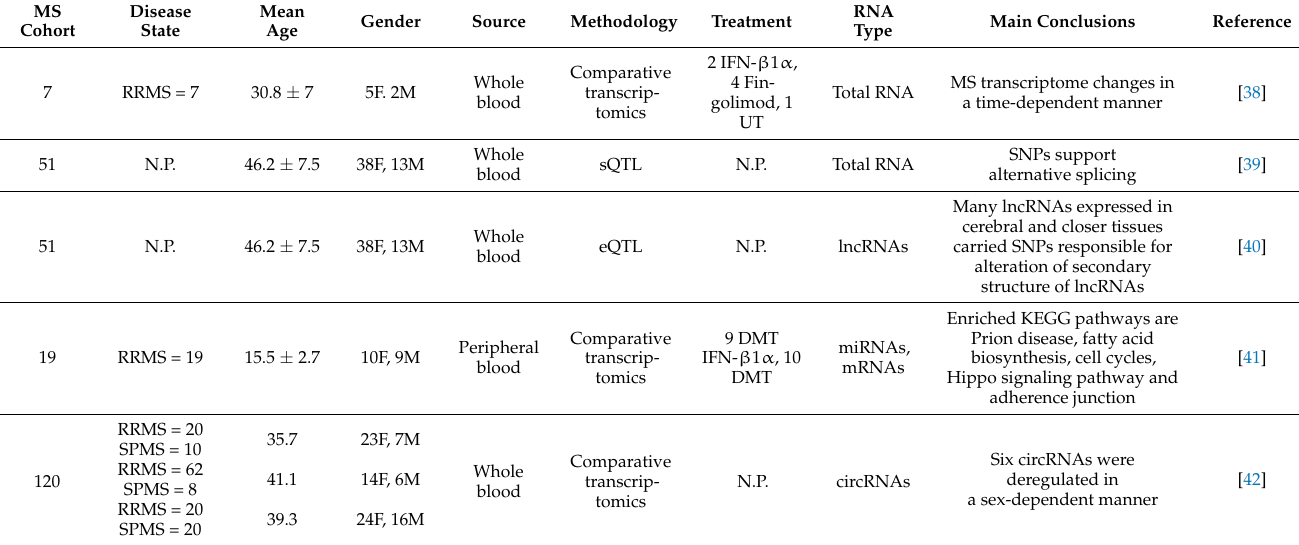
Table 3. Overview of the studies exploring transcriptomes in the human